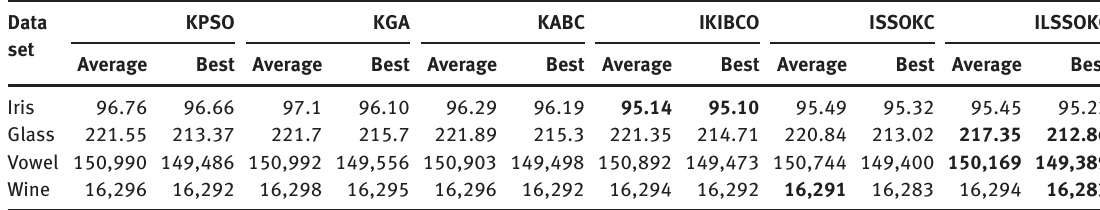
Table 9: SICD Comparison: Hybrid Clustering Algorithms.